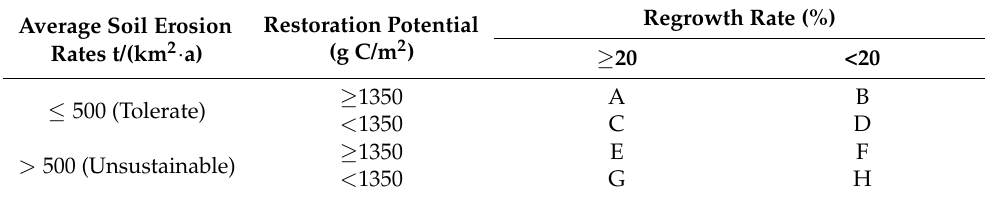
Table 3. Grassland regionalization criteria for ecological restoration. Average Soil